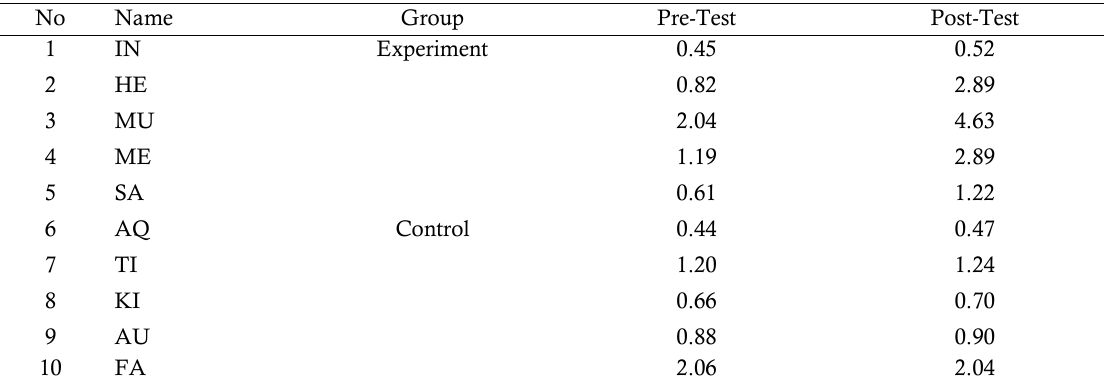
Table 3. Academic Burnout Scores from pre-test and post-test results